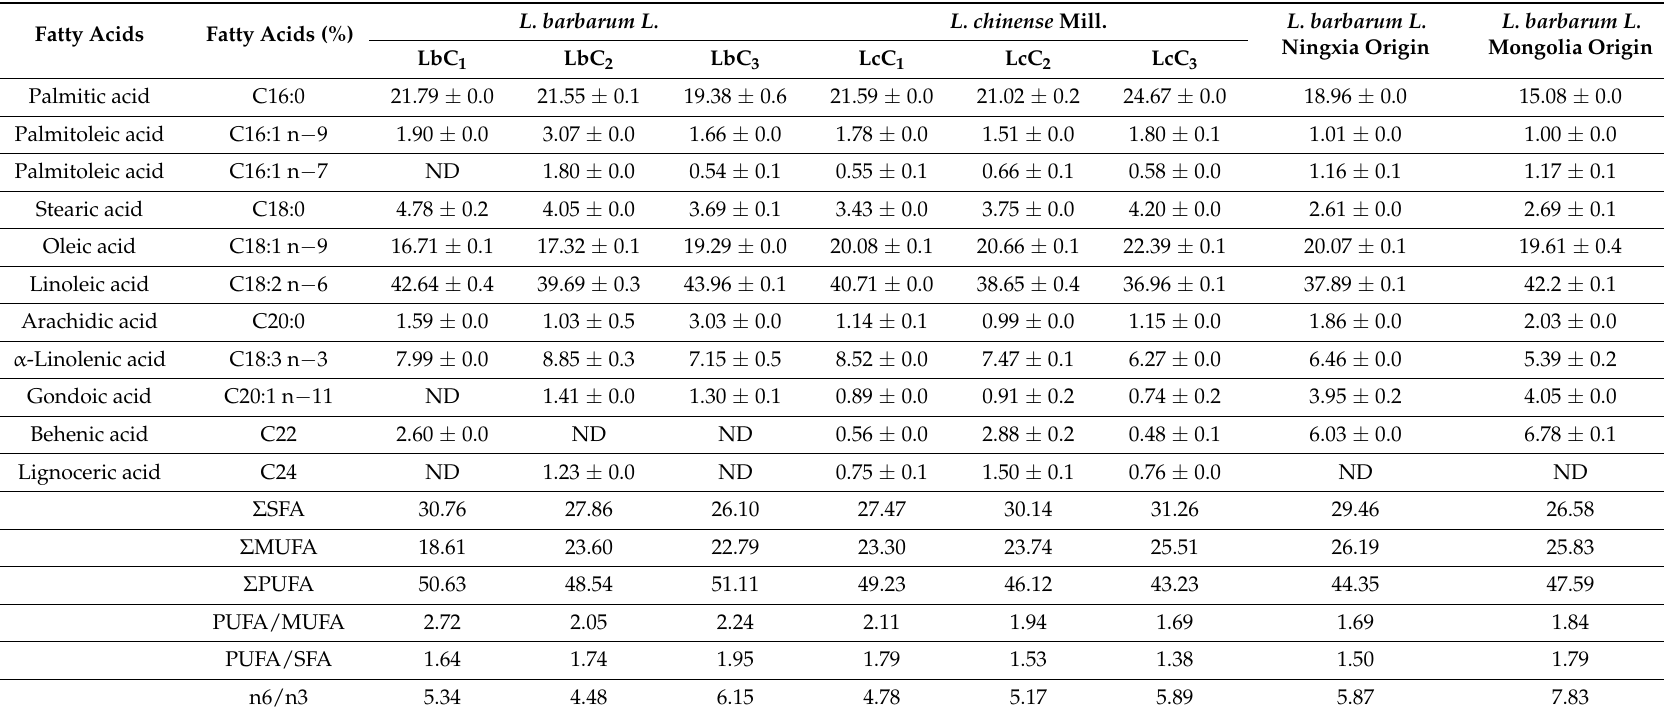
Table 2. Fatty-acid composition and nutritional ratios from goji berry